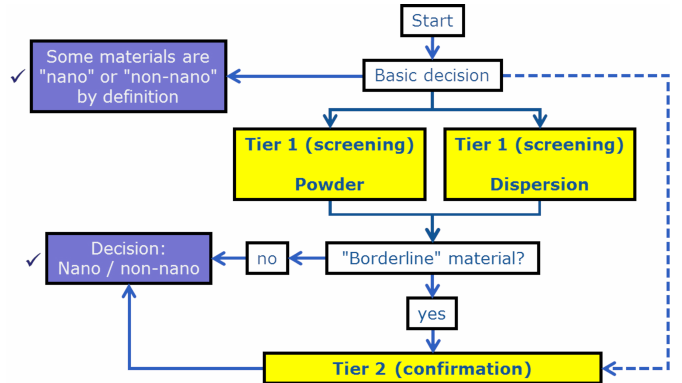
Figure 2. Simplified representation of the NanoDefine Decision Support Flow Scheme. Beside nano and non-nano also a borderline decision is a possible (but intermediate) result of Tier 1 methods. In such cases confirmation via Tier 2 methods is necessary to decide whether a material is nano or